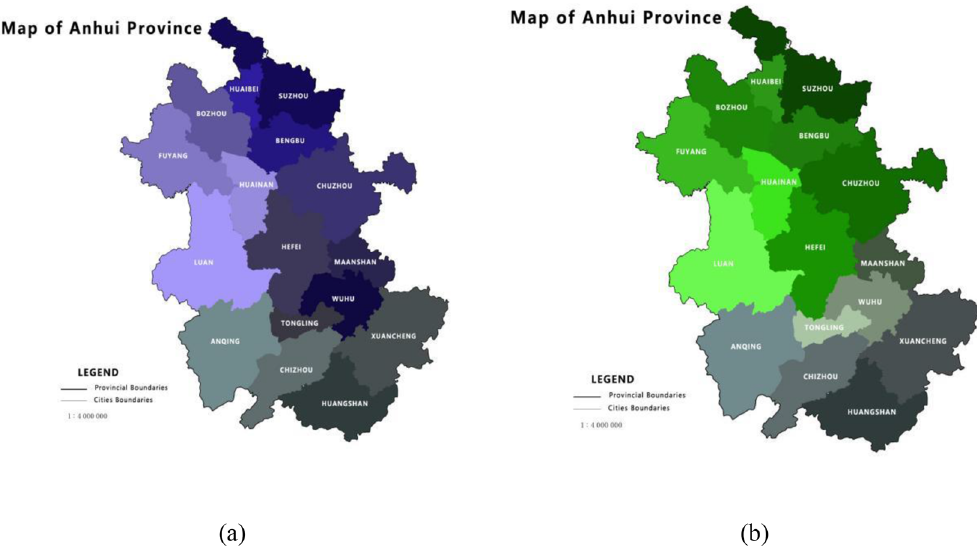
Figure 3. ( a ) The level of ecological liveability in Anhui Province; ( b ) The level of rural civilization in Anhui Province.